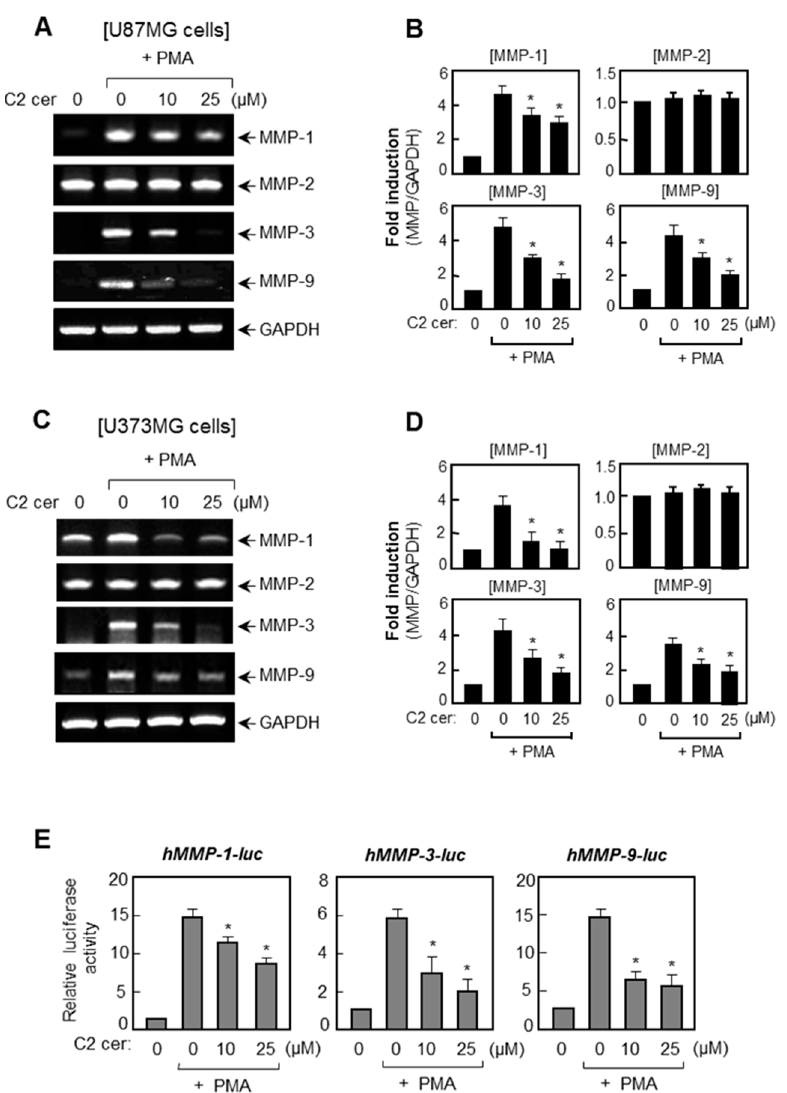
Figure 1. C2 ceramide suppresses the mRNA levels and promoter activities of MMP-1, -3, and -9 in U87MG cells. ( A – D ) Cells were treated with C2 ceramide for 1 h before stimulation with phorbol myristate acetate (PMA) (50 ng/mL) for 6 h, and total RNA was isolated. Then, RT-PCR was performed to detect MMPs expressed from U87MG ( A ) and U373MG cells ( C ); Quantification of RT-PCR data are shown in the right panel ( B ; U87MG, D ; U373MG cells); and ( E ) U87MG cells were transfected with MMP-1 , -3 , and -9 reporter plasmids, and treated with C2 ceramide in the absence or presence of the PMA for 16 h. Then, cells were harvested and the luciferase assay was performed using the cell lysates. Data are the mean ± S.E.M. of three independent experiments. * p < 0.05, significantly different from PMA-treated samples.